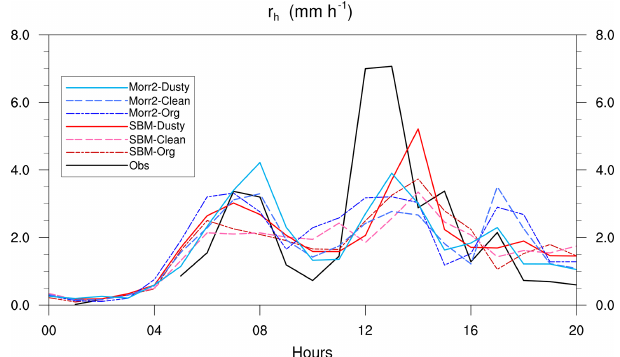
Figure 4. Hourly rainfall rates from IMERG observation (black line) and six numerical runs (colored lines) (00:00–20:00LT, 8 July 2006), averaged among rainfall grids ( > 0mmh − 1 ) in the High-Pcp